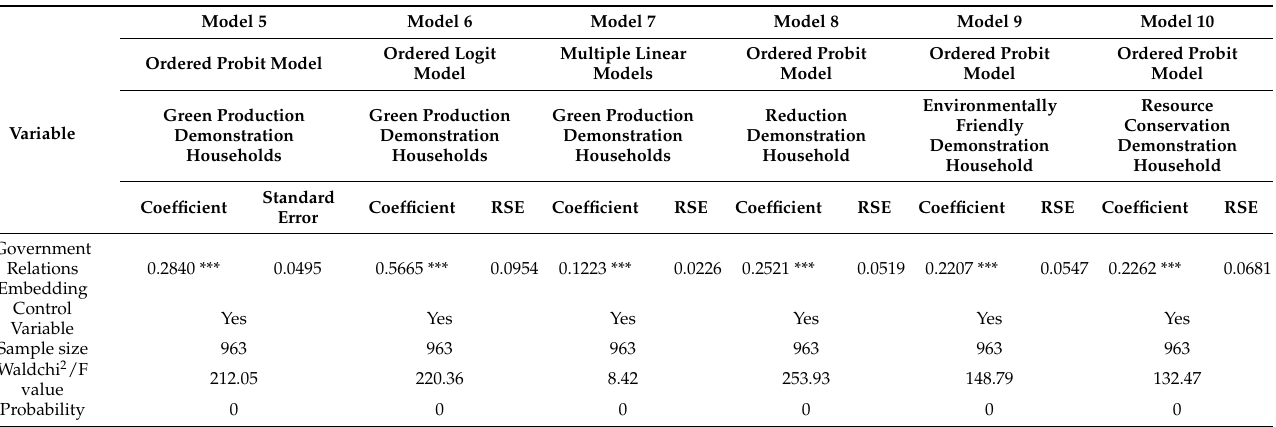
Table 5. Robustness Test